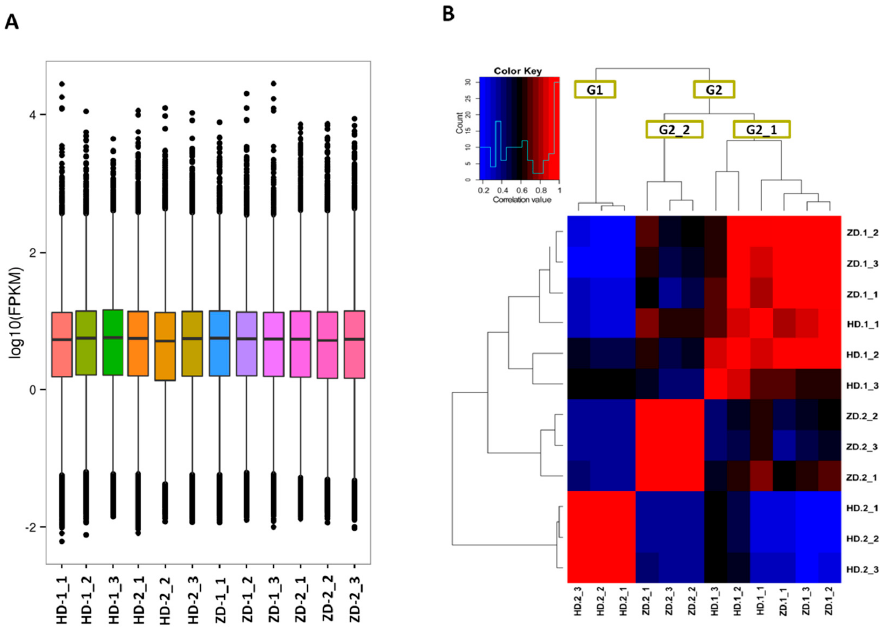
Figure 3. Overview of the transcriptome sequencing in L. indica leaves. ( A ) Gene expression profiles in the 12 libraries. HD represents the cultivar Lagerstroemia Dynamite, while ZD represents the cultivar Lagerstroemia Ebony Embers; ( B ) heatmap clustering showing correlation among samples based on global expression profiles. G1 and G2 represent the two major groups of samples, while G2_1 and G2_2 represent the subgroups of the group G2.